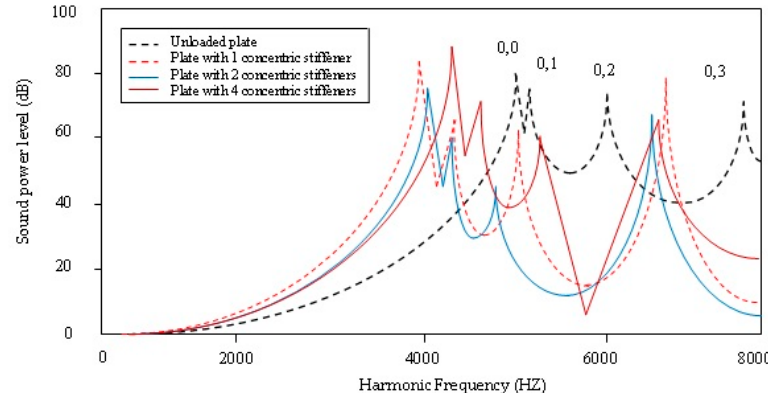
Figure 19. Numerical comparison of sound power level for annular plate having parabolic decreasing thickness variations (Case I) for different combinations of concentric stiffener patches for taper ratio T x = 0.75.